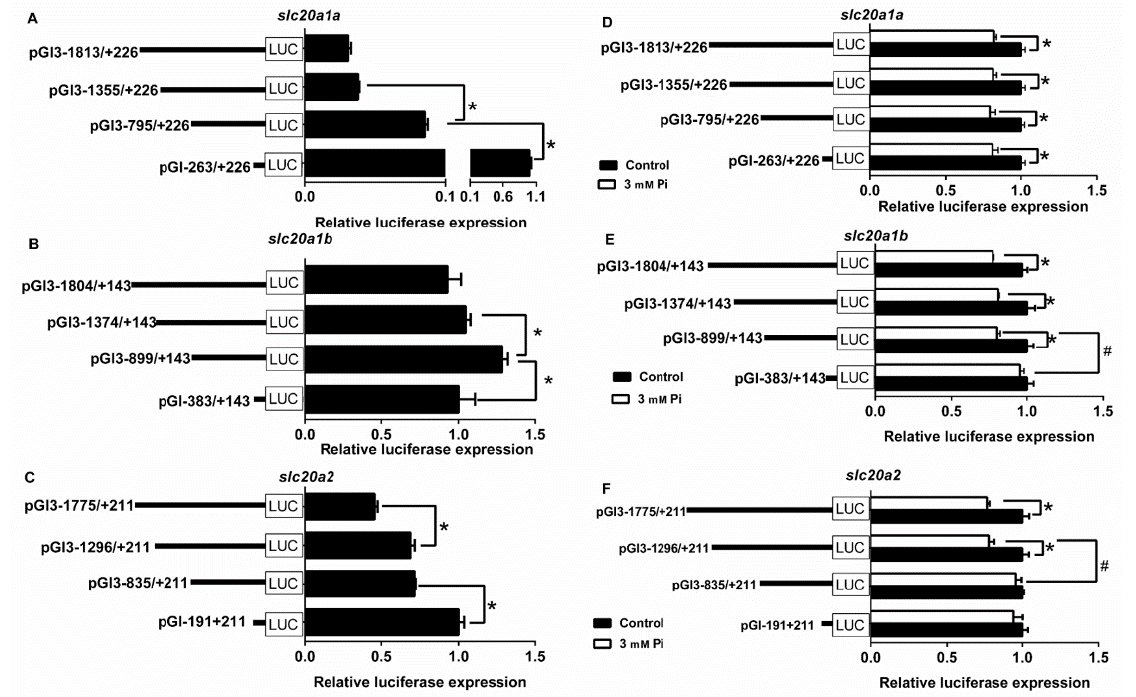
Figure 2. 5 (cid:48) unidirectional deletion analysis of the slc20a1a , slc20a1b and slc20a2 promoter regions for Ctenopharyngodon Idella . ( A ) A series of plasmids containing 5 (cid:48) unidirectional deletions of the slc20a1a promoter region (pGl-1813 /+ 226, pGl-1355 /+ 226, pGl-795 /+ 226, and pGl-263 /+ 226) fused in frame to the luciferase gene were transfected into HEK293T cells. ( B ) A series of plasmids containing 5 (cid:48) unidirectional deletions of the slc20a1b promoter region (pGl-1804 /+ 143, pGl-1374 /+ 143, pGl-899 /+ 143, and pGl-383 /+ 143) fused in frame to the luciferase gene were transfected into HEK293T cells; ( C ) a series of plasmids containing 5 (cid:48) unidirectional deletions of the slc20a1a promoter region (pGl-1775 /+ 211, pGl-1296 /+ 211, pGl-835 /+ 211, and pGl-191 /+ 211) fused in frame to the luciferase gene were transfected into HEK293T cells; ( D ) e ff ect of Pi incubation on the promoter activity of slc20a1a plasmids with di ff erent length; ( E ) e ff ect of Pi incubation on the promoter activities of slc20a1b plasmids with di ff erent length; ( F ) e ff ect of Pi incubation on the promoter activities of slc20a1b plasmids with di ff erent length; values represent the ratio between firefly and Renilla luciferase activities. Results are expressed as the mean ± SEM arbitrary units of three independent experiments). Student’s t-test was undertaken to detect the di ff erences between two treatments. Symbol (*) indicates significant di ff erences between the two group ( p < 0.05). Hash symbol (#) indicates significant di ff erence between the same Pi incubation groups with di ff erent deletion